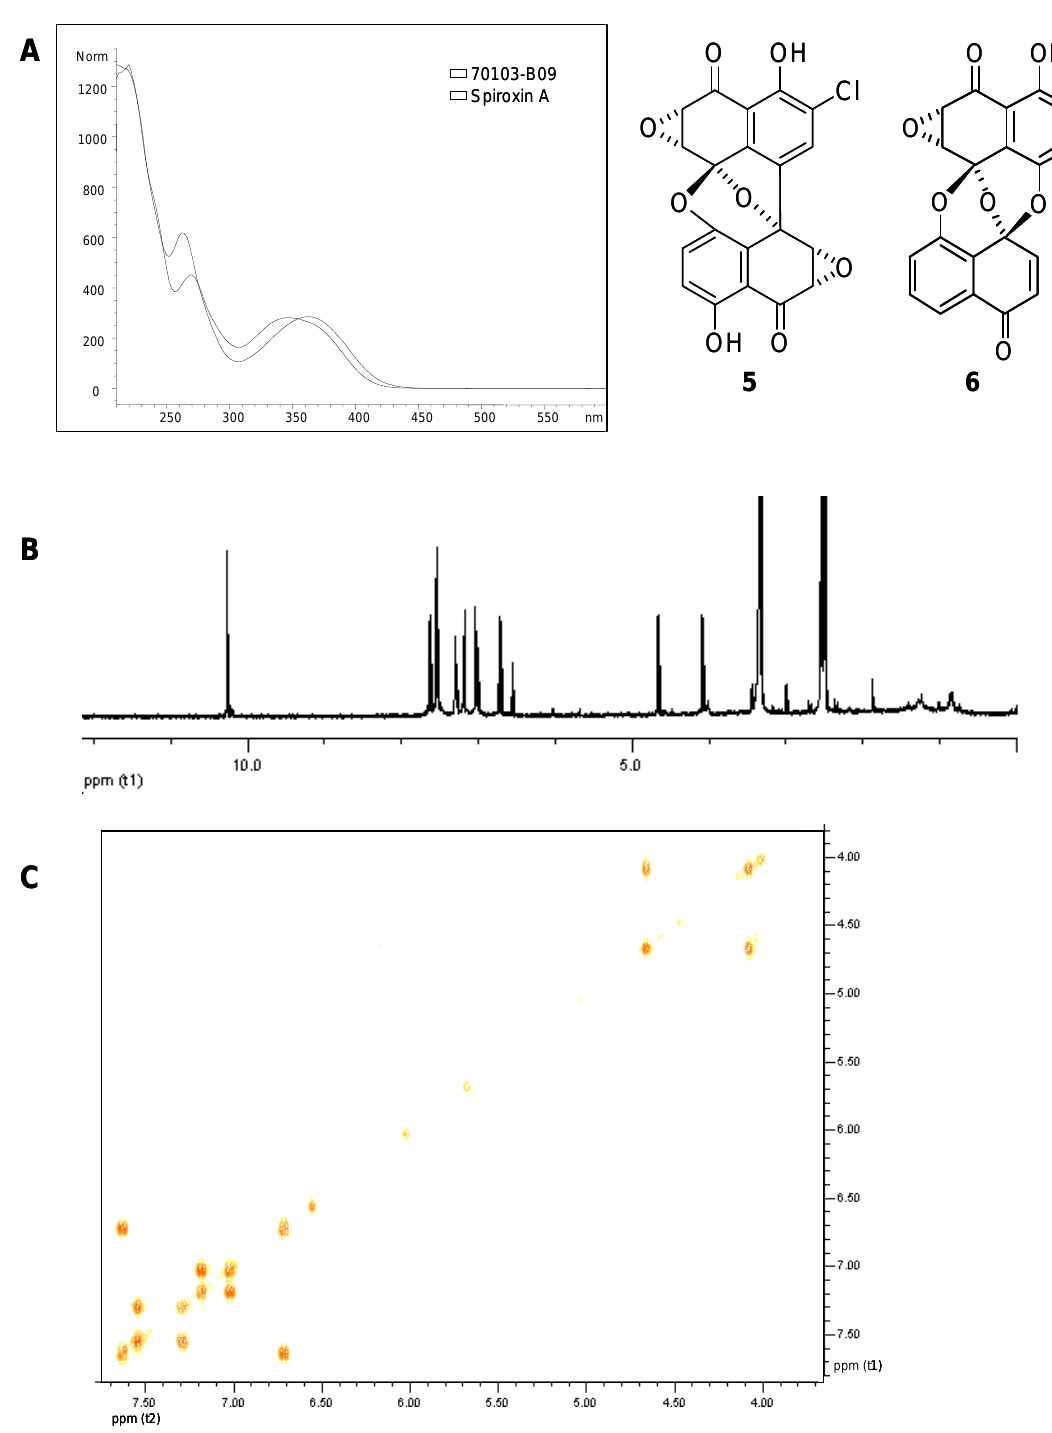
Figure 9. Analytical data for 70103-B09 used for identification of the major component. A) UV spectrum of 70103-B09 overlaid with the UV spectrum of spiroxin A ( 5 ). B) 1 H- NMR spectrum of 70103-B09 in DMSO-d6. C) 1 H- 1 H COSY spectrum of 70103-B09 in DMSO-d6